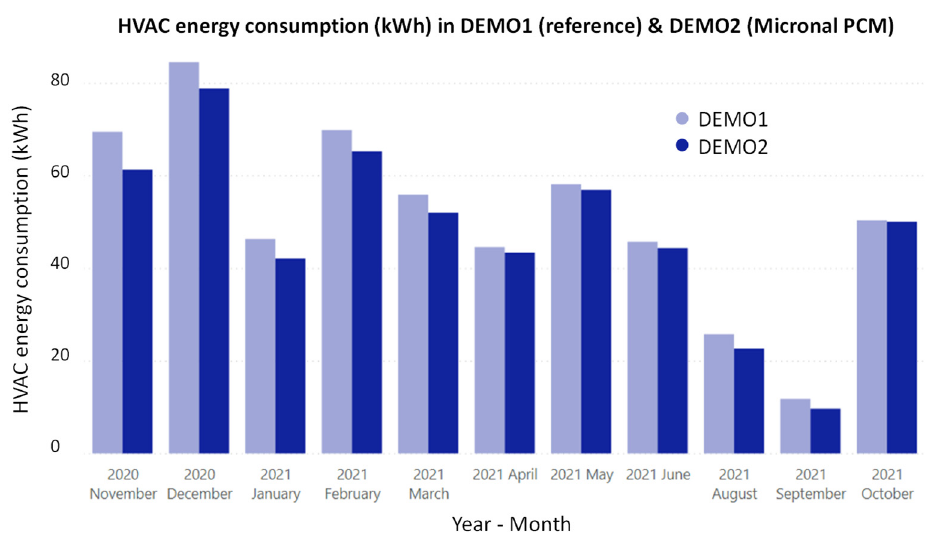
Figure 11. HVAC system energy use during Micronal testing under ‘Conditioned mode’.